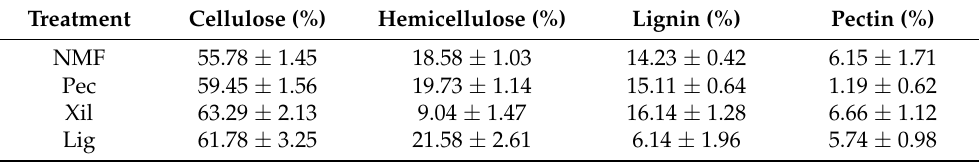
Table 3. Chemical composition of fique fiber after treatment with lignocellulolytic enzymes. Treatment